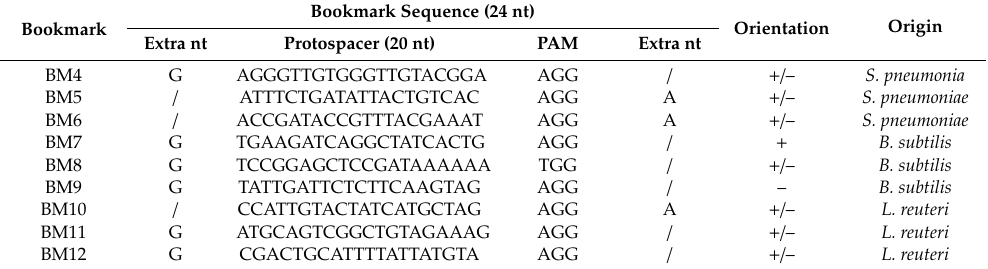
Table 3. Summary of the bookmark sequences. Nine protospacers were picked from the literature as successful examples of SpCas9 targets in bacterial species [17–19]. To constitute a bookmark, each protospacer should be immediately followed by a PAM (suggested: AGG) and complemented with one single nucleotide at either extremity. For each bookmark, the position of the extra nucleotide as well as the orientation of the bookmark relative to the coding sequence (CDS) it replaces are given to avoid internal STOP codons. “ + ”: same direction as the target CDS, “ – ”: reverse-complementary direction relative to the target CDS, “ +/ –”: either same or reverse-complementary direction relative to the target CDS, S. pneumonia: Streptococcus pneumonia, B. subtilis: Bacillus subtilis, L. reuteri = Lactobacillus